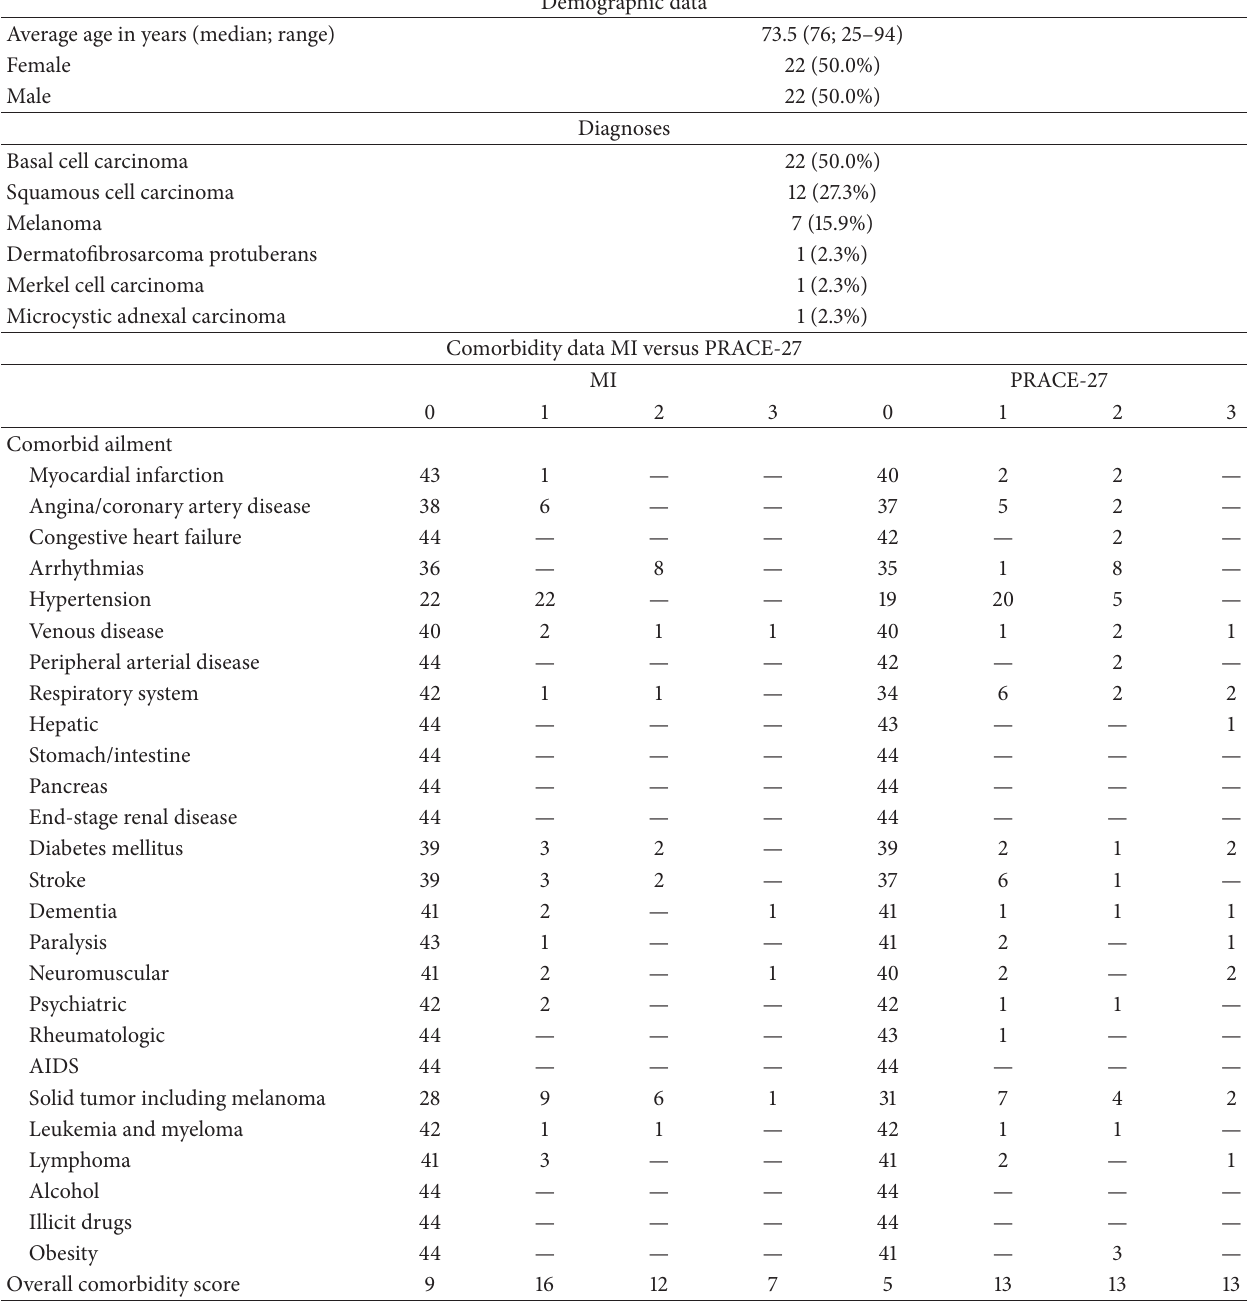
Table 1: Patient demographic data, lesion information, and comorbidity